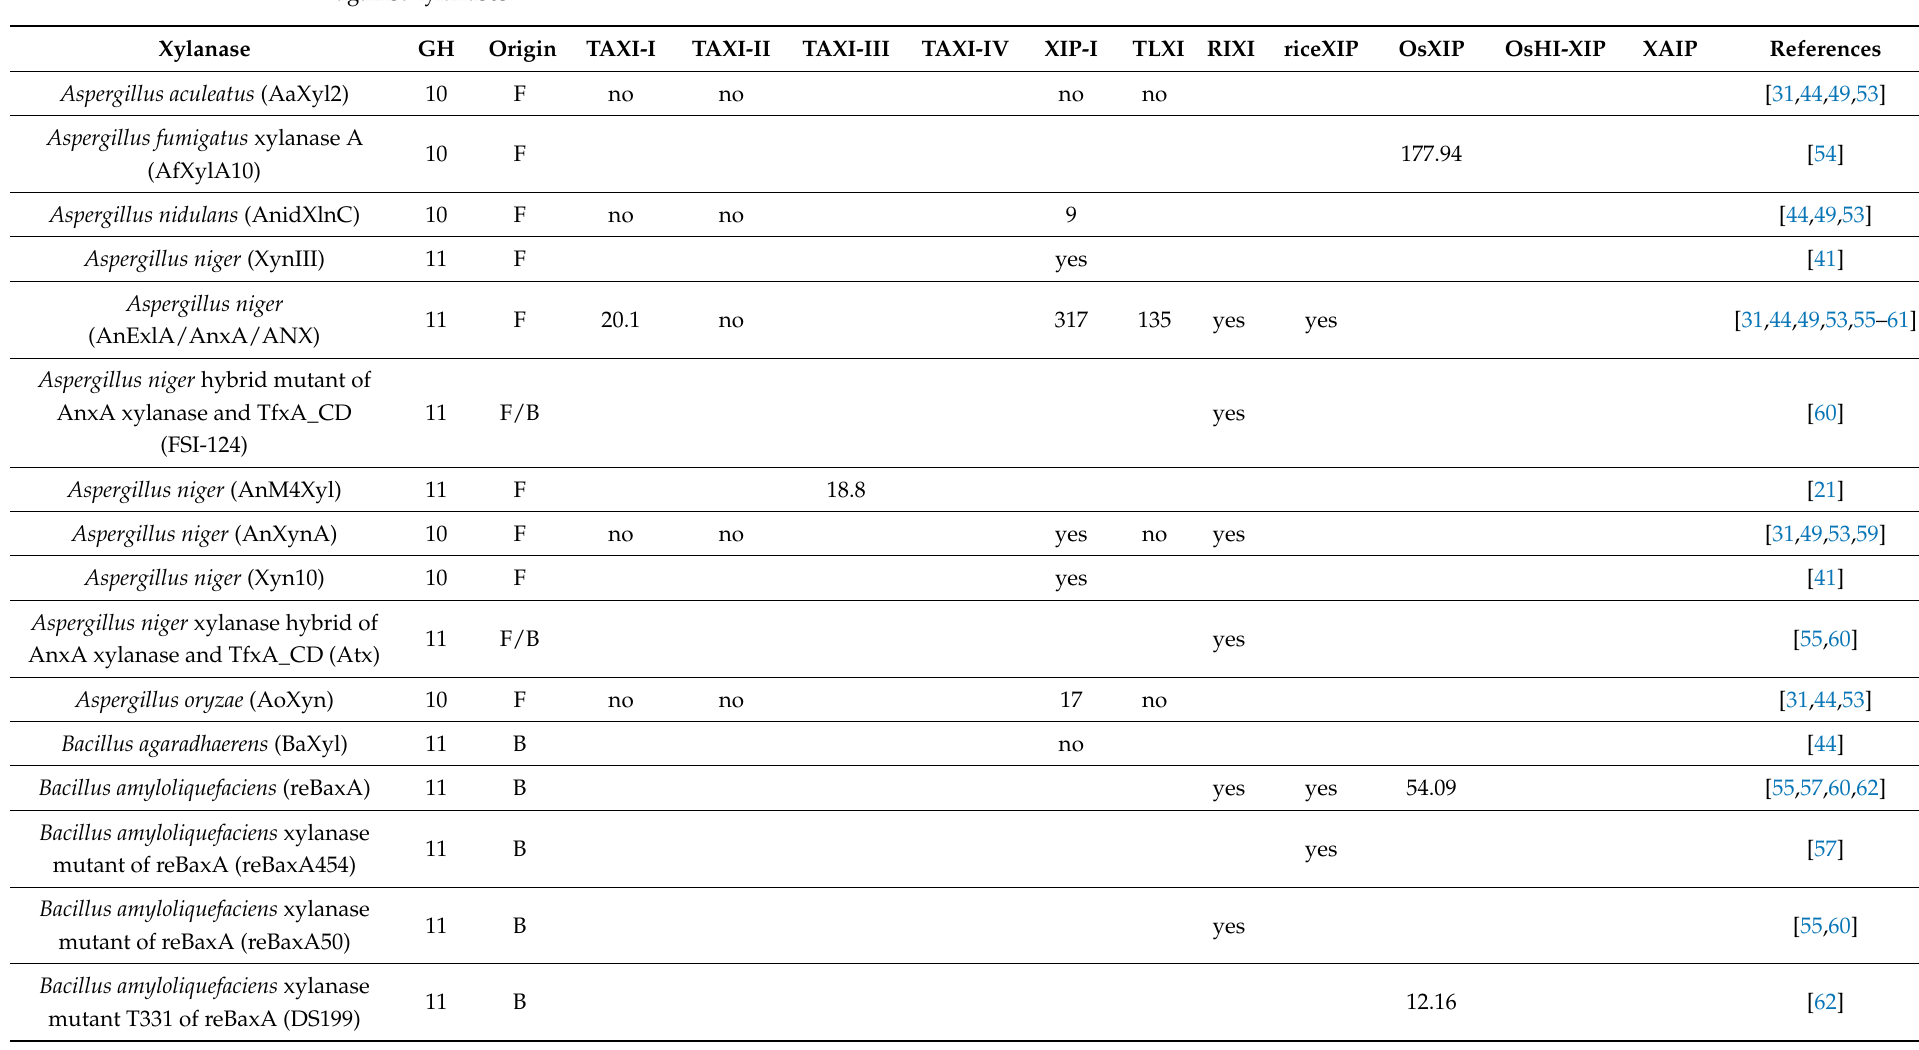
Table 1. Inhibitory activity and Ki values of wheat (TAXI, XIP, TLXI), rice (RIXI, riceXIP, OsXIP, OsHI-XIP), and Scadoxus multiflorus (XAIP) xylanase inhibitors against